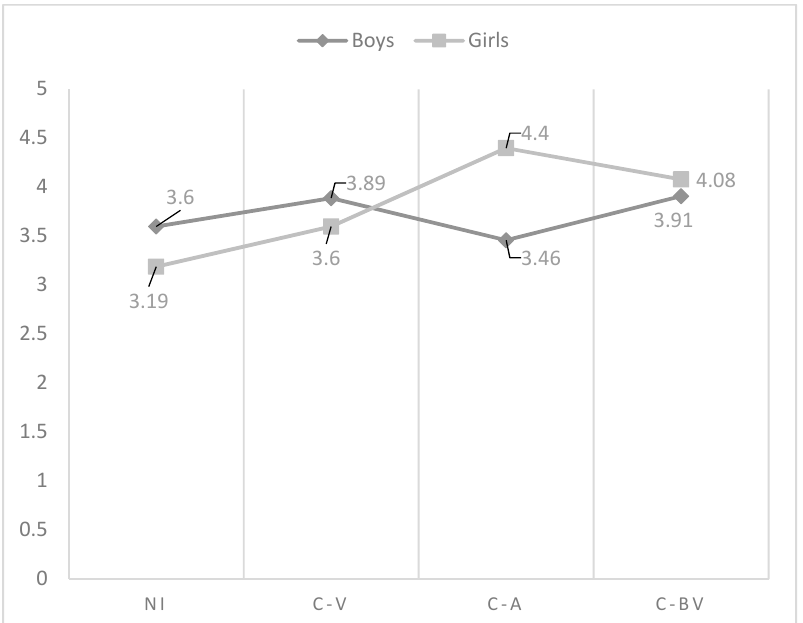
Figure 3. Effect of the interaction of gender and cyberbullying roles on mother inductive discipline. Notes: NI = Non-involved; C-V = Cyber-victim; C-A = Cyber-Aggressor; C-BV = Cyber-bully/victim.